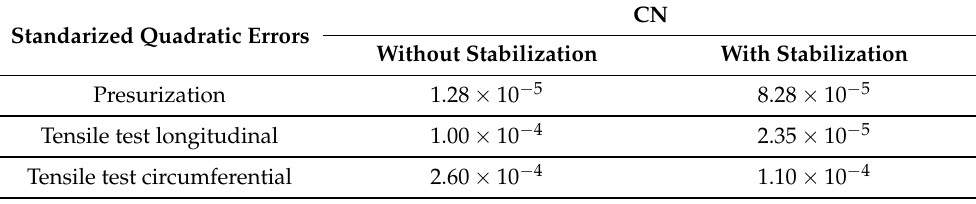
Table 5. Standardized Quadratic Errors of the CN